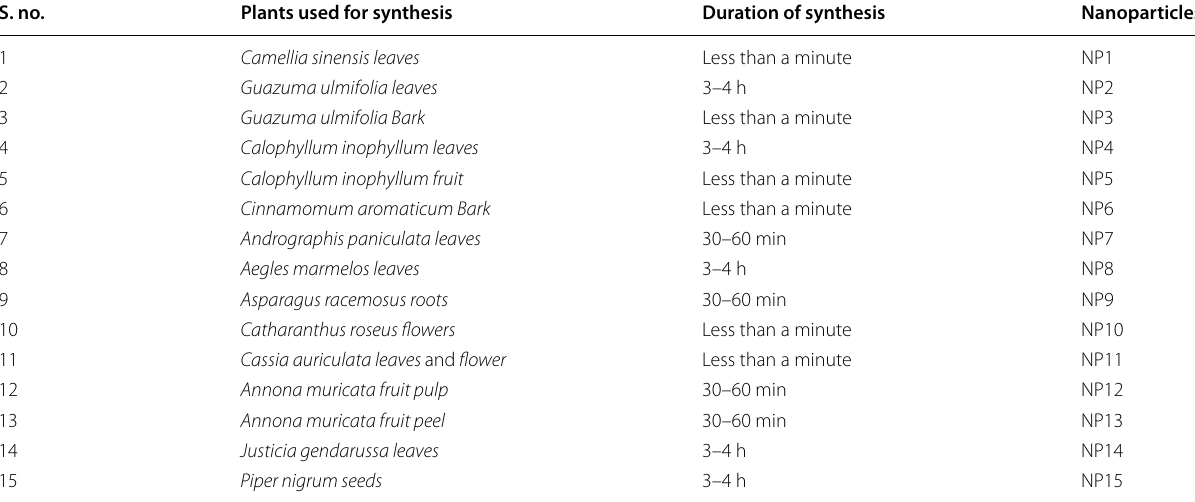
Table 2 Duration of nanoparticles synthesis S.